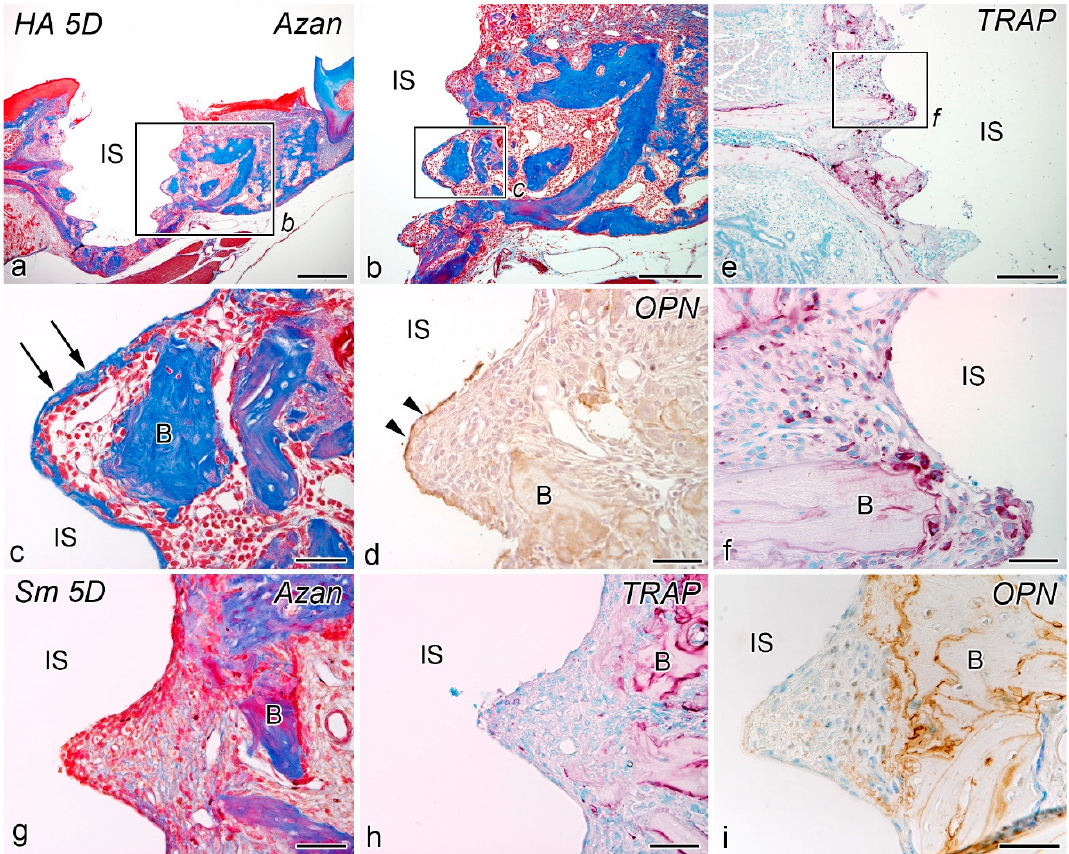
Figure 2. Azan staining ( a – c , g ), TRAP reaction ( e , f , h ), and OPN-immunoreactivity ( d , i ) in tissues surrounding the implants in the HA ( a – f ) and Sm groups ( g – i ) at day 5 after implantation. ( b , c , f ) are the higher magnifications of the boxed areas in ( a , b , e ), respectively. ( a – f ) Granulation progresses at the bone-implant interface and bone formation has begun on the implant surface. TRAP-positive osteoclast lineage cells appear around the implants, and an OPN-positive reaction (arrowheads) is observed at the bone-implant interface. ( g – i ) No bone formation is observed around the implant. Arrows, direct osteogenesis; B, bone; IS, implant space. Scale bars = ( a ) 500 μ m, ( b , e ) 250 μ m, and ( c – i ) 50 μ m.